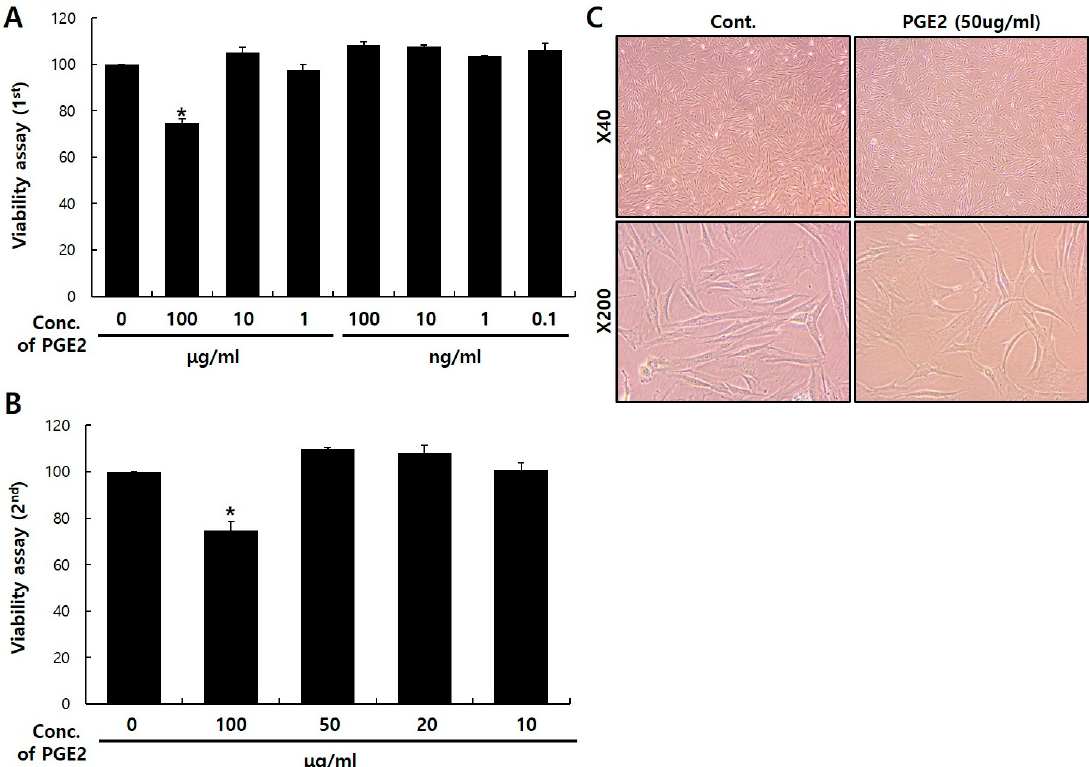
Figure 1. Viability and characterization of prostaglandin E synthases 2 (PGE2) treatment in normal human dermal fibroblasts (NHDFs). NHDFs were seeded in 96-well plates at a density of 2 × 10 3 cells per well and treated with PGE2 ( A , B ). Cell viability results, based on a Cell Counting Kit-8 (CCK-8) assay, are presented as the mean ± standard deviation (SD) of the percentage of the control optical density (OD). ( C ) NHDF morphologies were visualized with phase contrast microscopy ( × 40, × 200). NHDFs were treated with 50 µ g / mL of PGE2 or dimethyl sulfoxide (DMSO) for 24 h. Values represent the mean ± SD of three independent experiments. * p < 0.05 compared to the control.